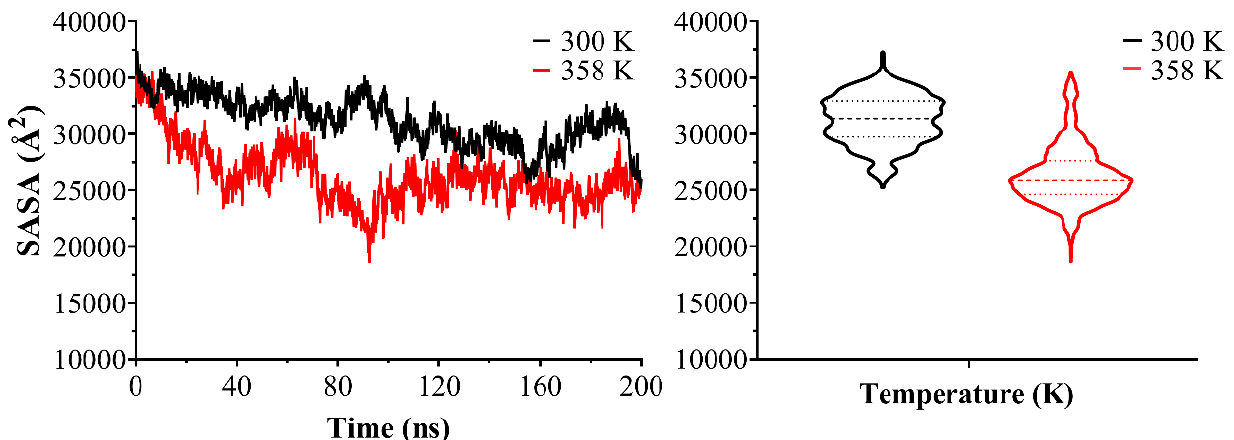
Figure 8. Solvent accessible surface area (SASA) as a function of simulation time for Mono-, Di- and Tri-glyceride Lauric acid at 300 K (black line) and 358 K (red line) during the self-association process.